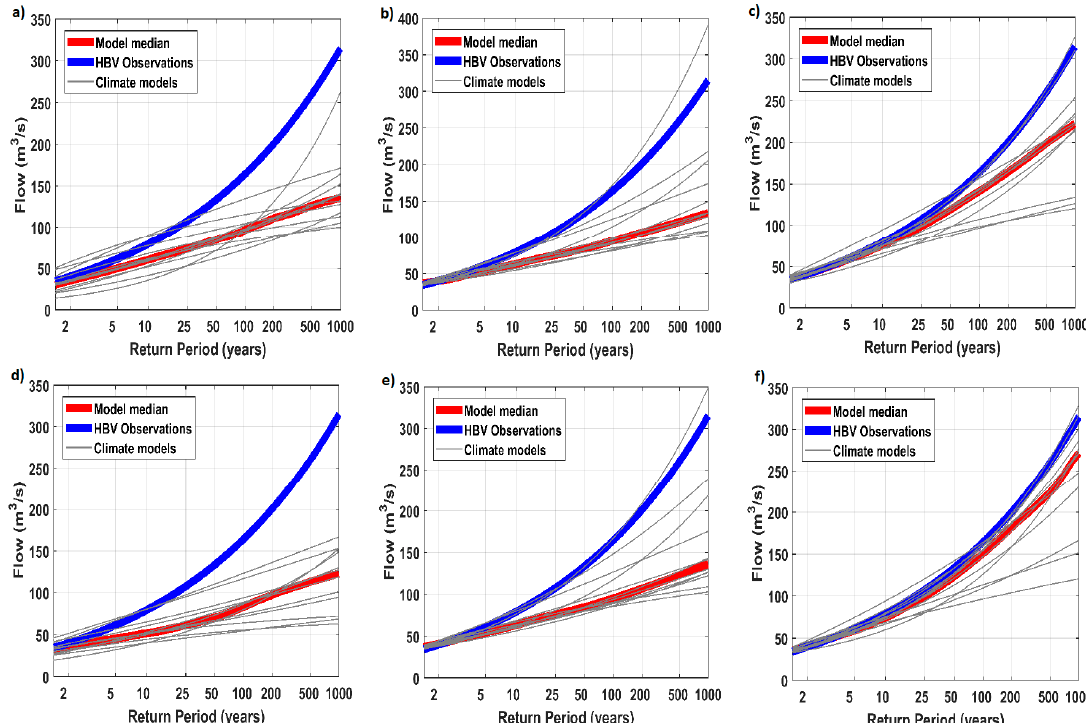
Figure 10. Comparison between flood frequency curves fitted to annual maximum series simulated by the HBV model with observed data and HBV simulations with climate projections in Porma catchment, using a set of combinations of bias correction techniques. Red lines represent the median of the 12 climate models considered. ( a ) Raw data with no bias correction; ( b ) raw temperature and precipitation with QM linear correction; ( c ) raw temperature and precipitation with QM polynomial correction; ( d ) raw precipitation and temperature bias corrected; ( e ) temperature bias corrected and precipitation with QM linear correction; ( f ) temperature bias corrected and precipitation with QM polynomial correction.